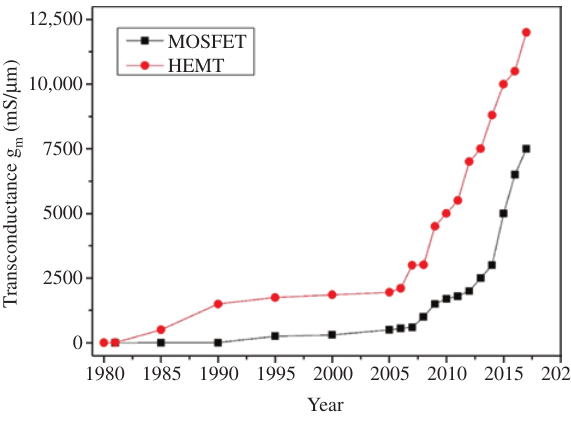
Figure 4: Record transconductance for InGaAs HEMT and MOSFET since their invention